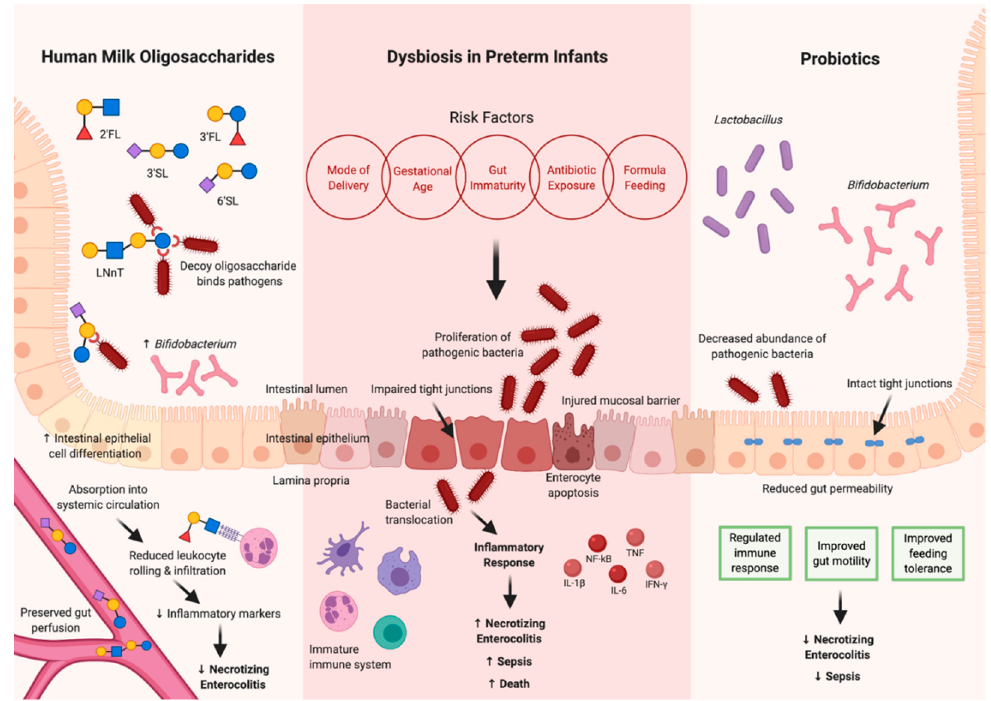
Figure 1. Effects of dysbiosis on the intestinal barrier in preterm infants and the protective effects of human milk oligosaccharides and enteral probiotics. Figure created with Biorender.com.